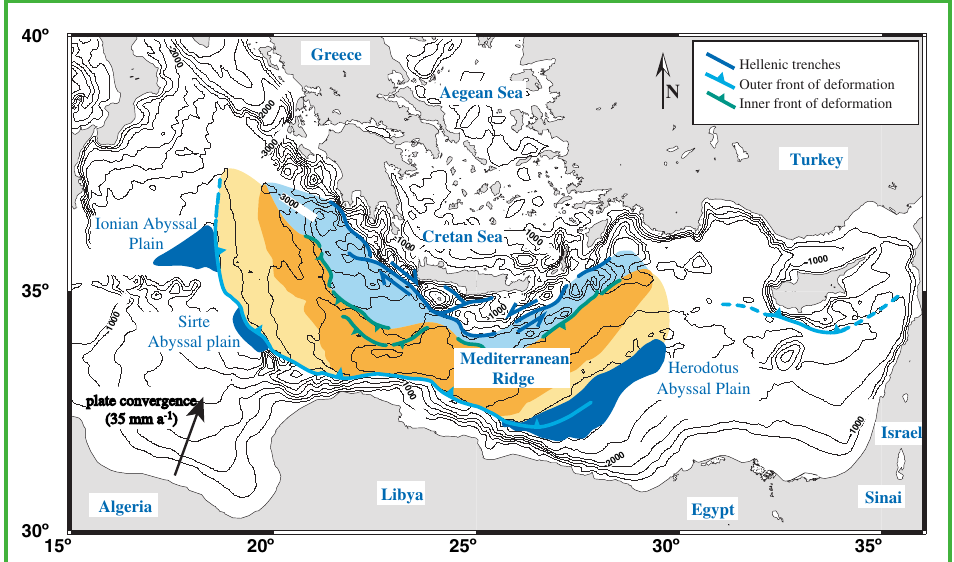
Figure 1. The Cretan Margin as part of the Hellenic subduction zone (HSZ); heavy colored lines with triangles = deformation front, accretionary complex in gray, inner ridge backstop domain in light